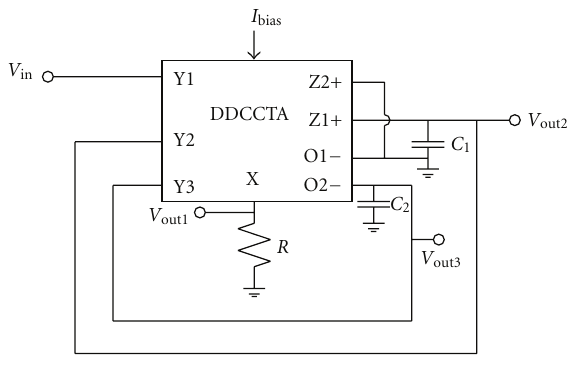
Figure 6: Proposed voltage mode filter. Table 2: Circuit performance parameters of the DDCCTA.